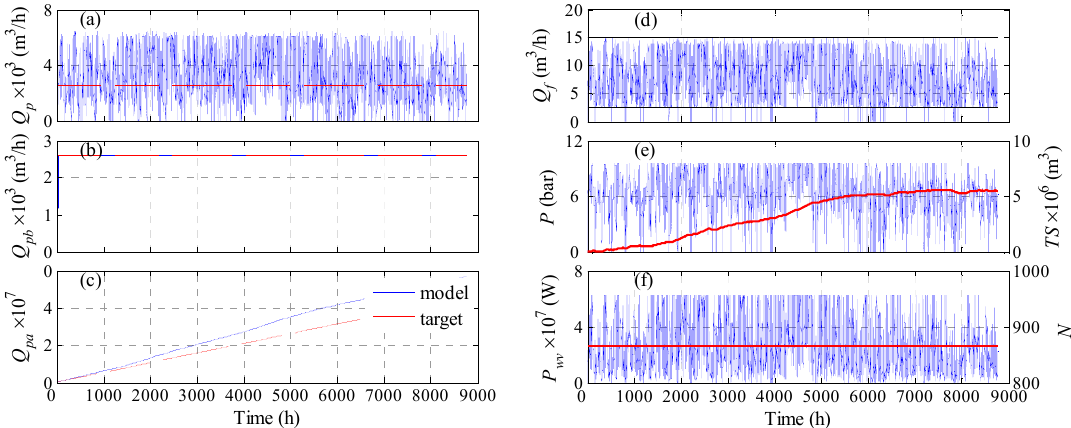
Figure 6. Optimization results for the case of variable pressure and optimized N WT and N v for satisfying the annual production rate using storage tanks; Q p : hourly production rate, Q pb hourly water supply in the pipeline, Q pa : accumulative production, Q f : hourly fee flow rate, P : feed pressure; P wv : supplied power per vessel.